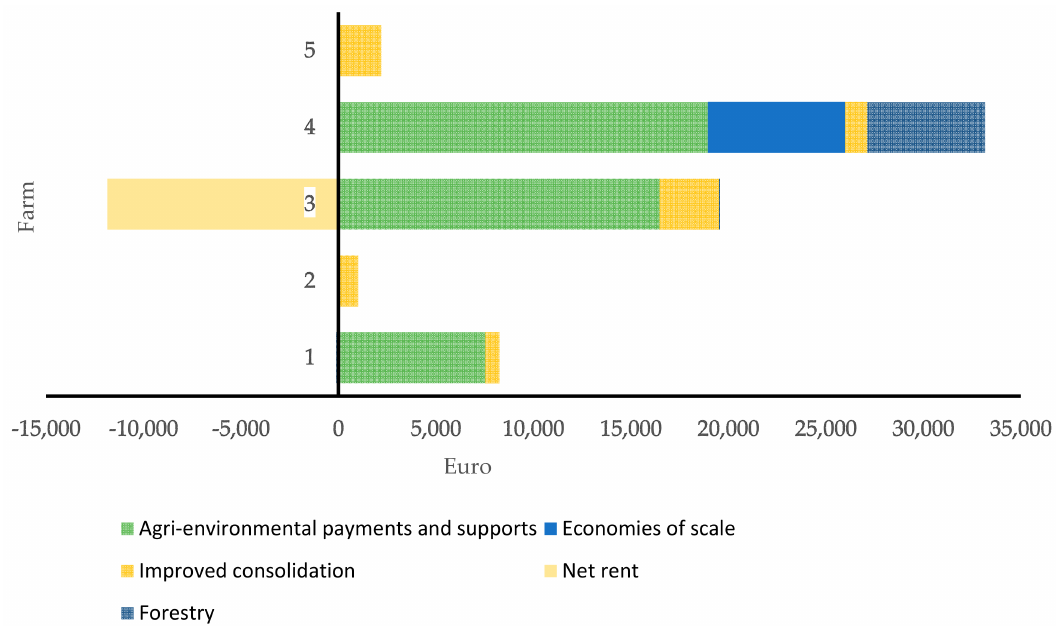
Figure 1. Magnitude, € after tax per farm and year, and reasons for profitability increases due to creation of large coherent pastures on five Swedish cow-calf